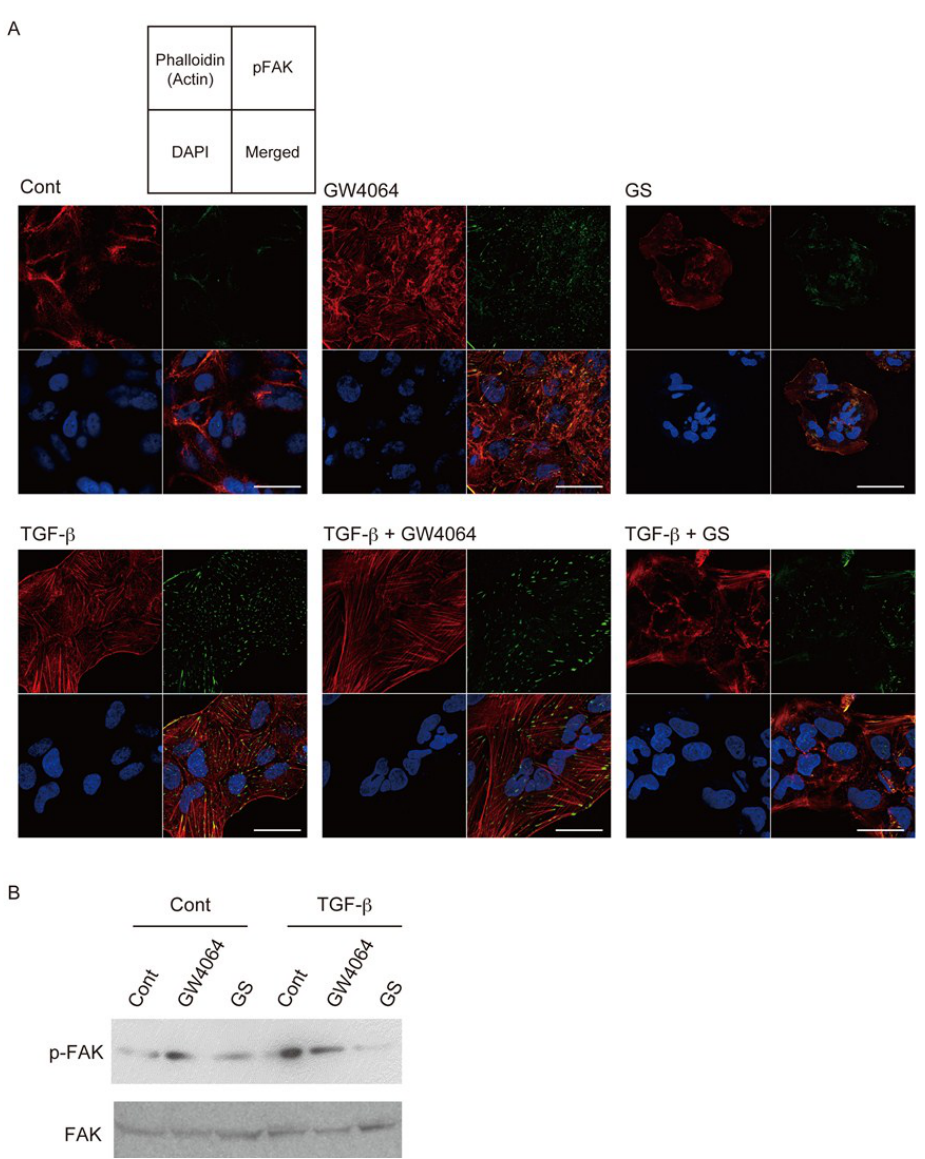
Figure 4. Combined effects of TGF-β and GW4064 or GS on phosphorylated FAK (p-FAK) expression in HuH-7 cells. ( A ) Actin polymerization ( red ) and phosphorylated FAK (p-FAK; green ); DAPI ( blue ); and ( B ) Western blotting for p-FAK and total FAK. Cells were treated with vehicle control (Cont), 10 μM GW4064, or 32 μM GS in the absence or presence of 10 ng/mL TGF-β for 48 h. Scale bar, 50 μm.